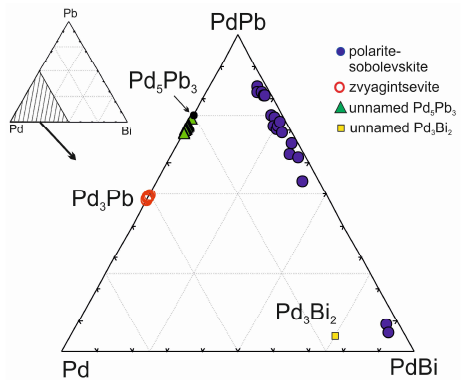
Figure 13. Position of zvyagintsevite, ploarite and sobolevskite from the Southern 2 orebody in the system Pd-PdPb-PdBi.